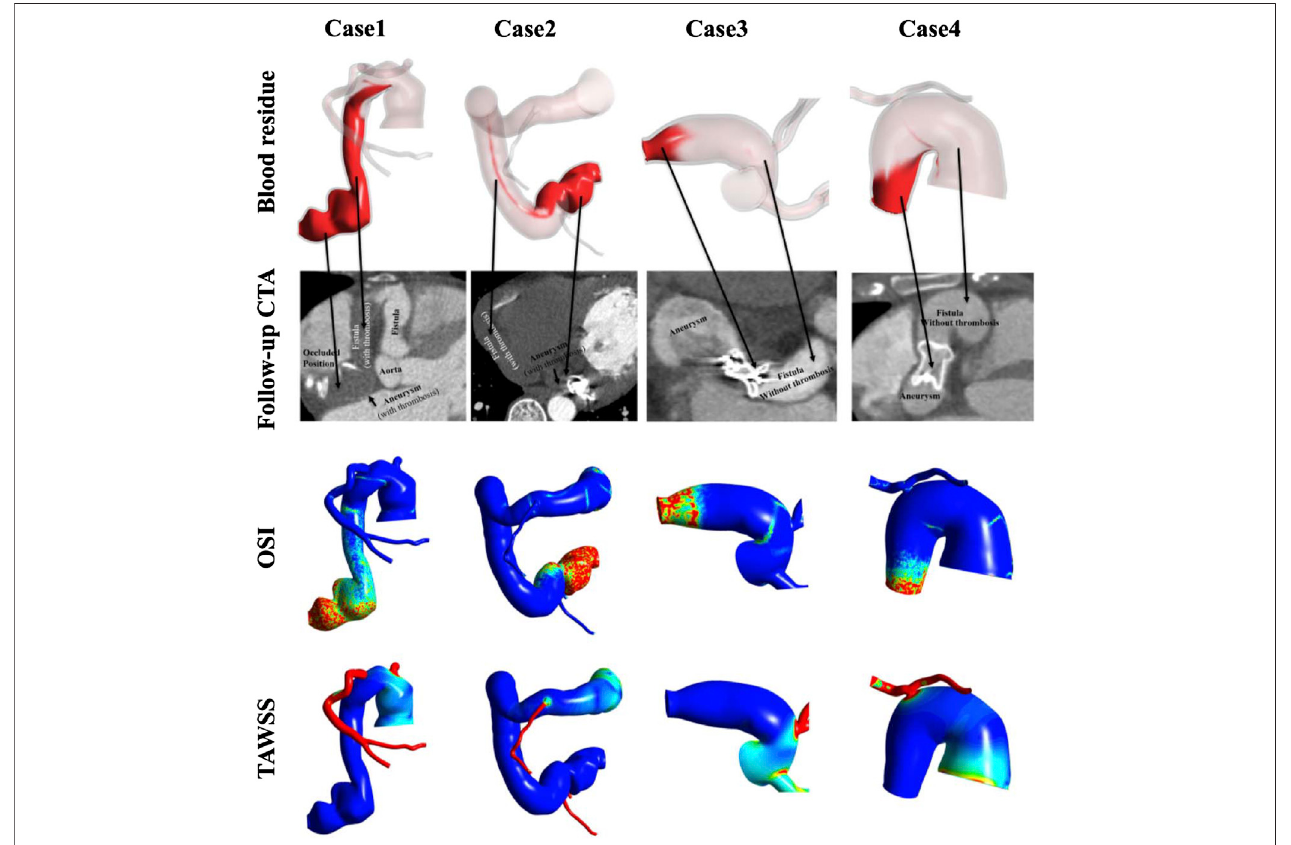
FIGURE 7 | Comparison of blood residue, the follow-up CT after the occlusion operation, and contours of OSI and TAWSS (in order from top to bottom) of the models under actual treatments.